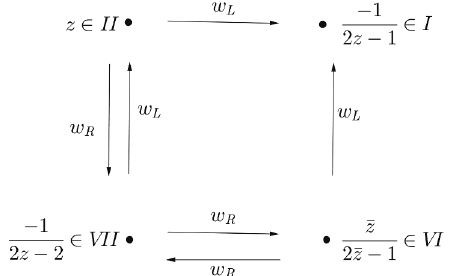
Figure 9. Closed graph describing the orbit of point z ∈ II . Out of region I are only z , w